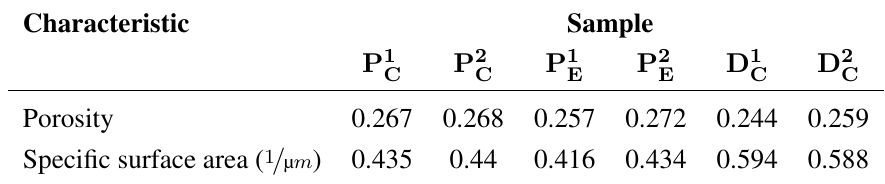
Table 3. Porosity and specific surface area computed for six selected binary images of anode